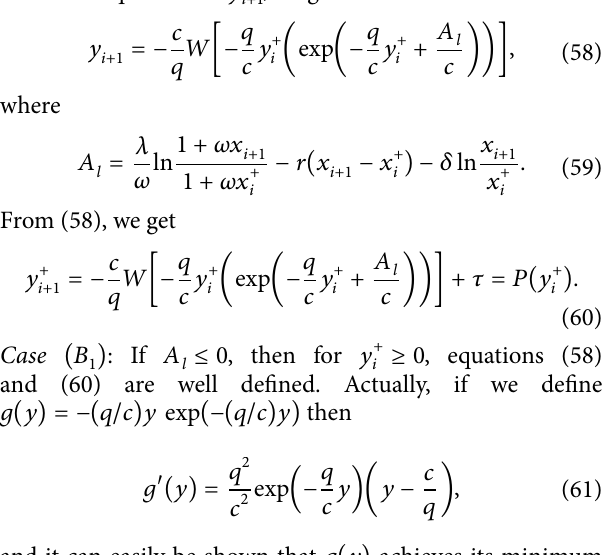
Figure 3: Fixed point of Poincaré map for Case 휏 = 0.12 휔 = 0.1